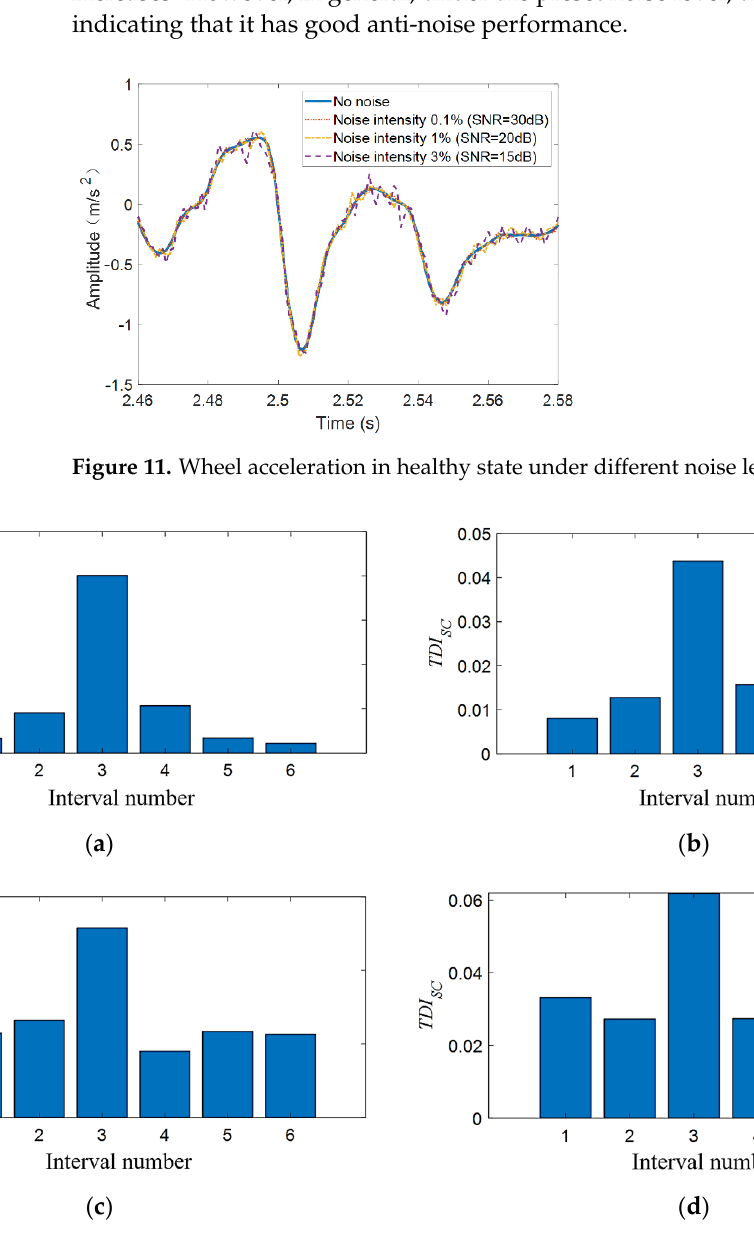
Figure 12. TDI SC under different noise levels when there is 6% tunnel stiffness damaged in the third interval: ( a ) no noise; ( b ) noise intensity of 0.1% (SNR = 30 dB); ( c ) noise intensity of 1% (SNR = 20 dB); and ( d ) noise intensity of 3% (SNR = 15 dB).